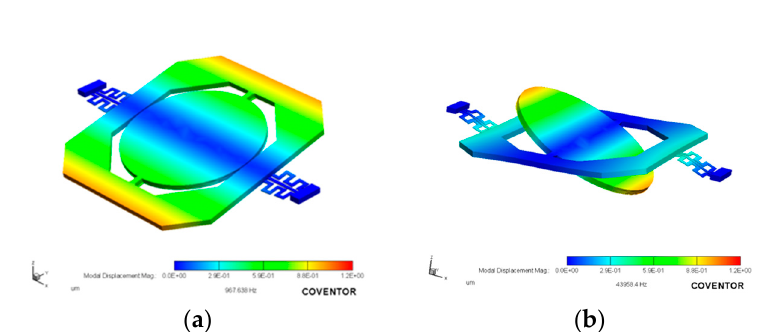
Figure 2. Finite-element simulation of the slow- and fast-axis modes in ( a ) and ( b